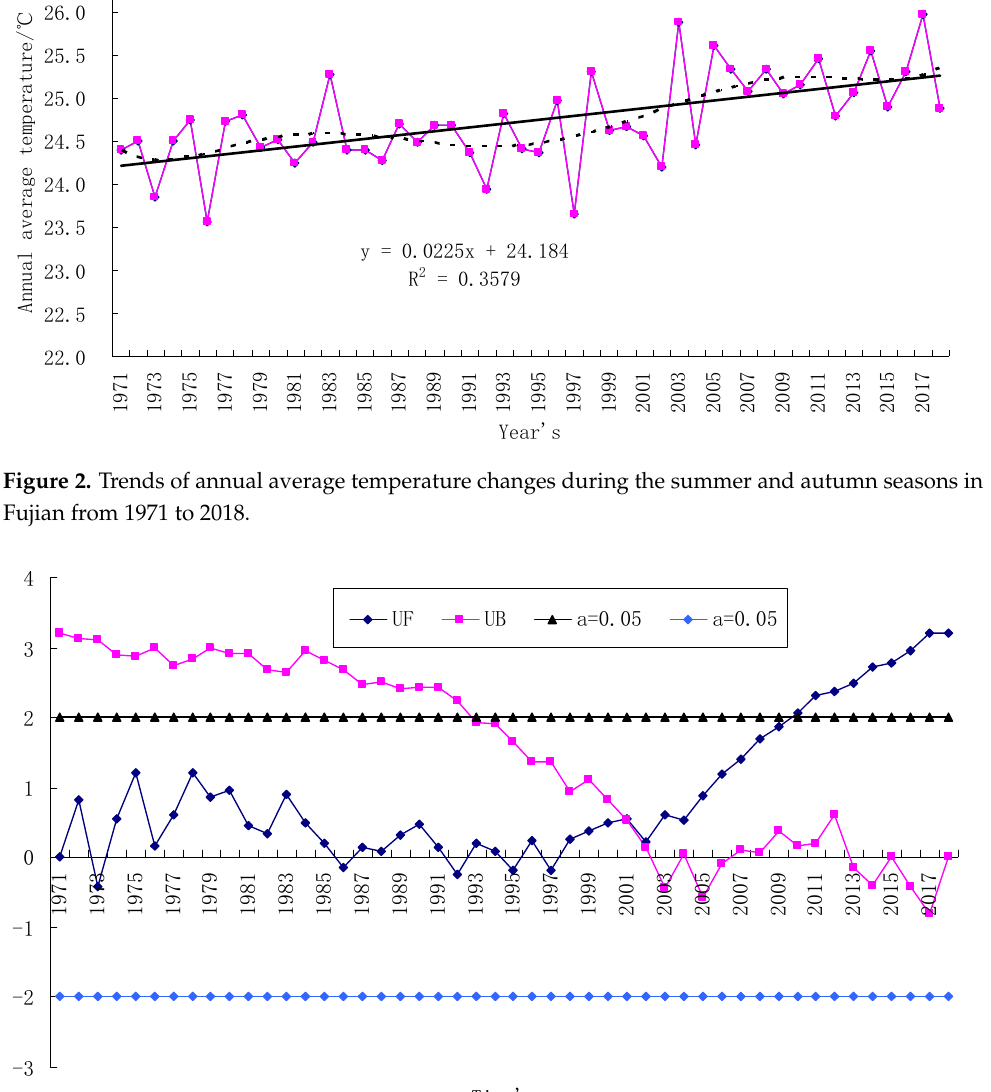
Figure 2. Trends of annual average temperature changes during the summer and autumn seasons in Fujian from 1971 to 2018.